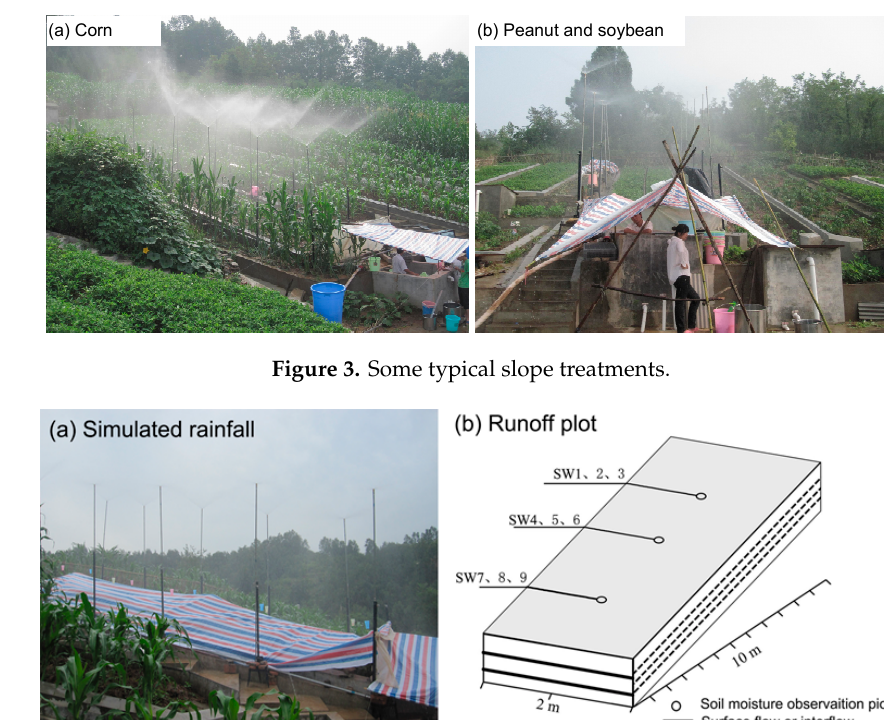
Figure 4. Artificial rainfall experiments on a runoff plot ( a ) and the location of soil moisture sensors in the runoff plot ( b